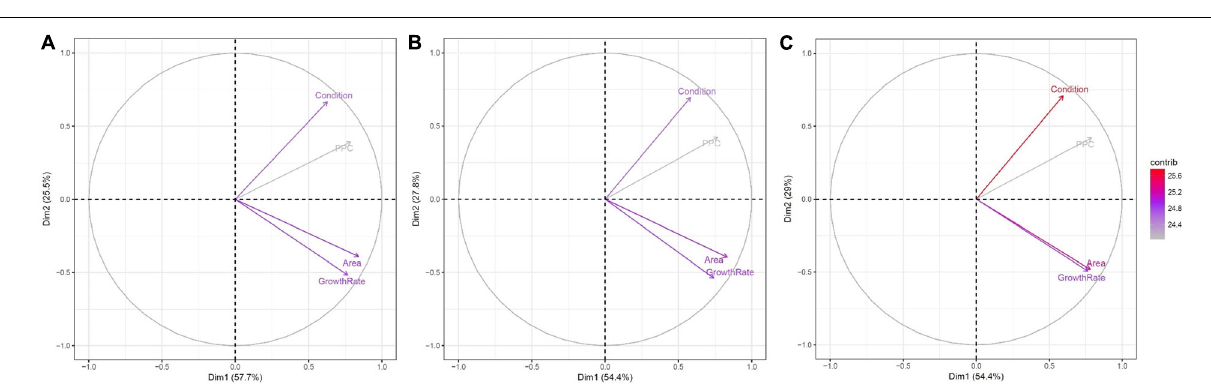
FIGURE 11 | Contribution of plant condition, area, maximum growth rate and PPC for all 200 accessions to principal components 1 ( x -axis) and 2 ( y -axis) for (A) all plants; (B) salt-treated plants; and (C) control plants. The values between the brackets indicate the percentage of variance explained by the individual principal components. Each trait’s contribution to the selected principal component is indicated by the length and color of the